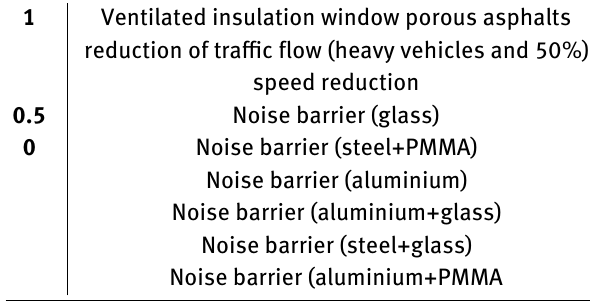
Table 6: Values assigned for reduced visibility 1